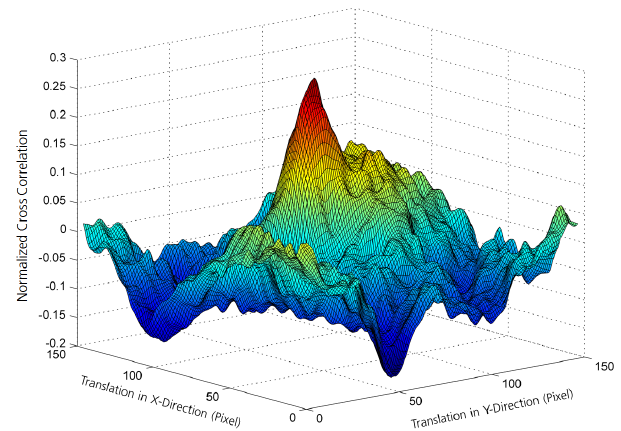
Figure 5. Normalized cross correlation between the TerraSAR-X image patch and the template generated from the first roundabout of the WorldView- 2